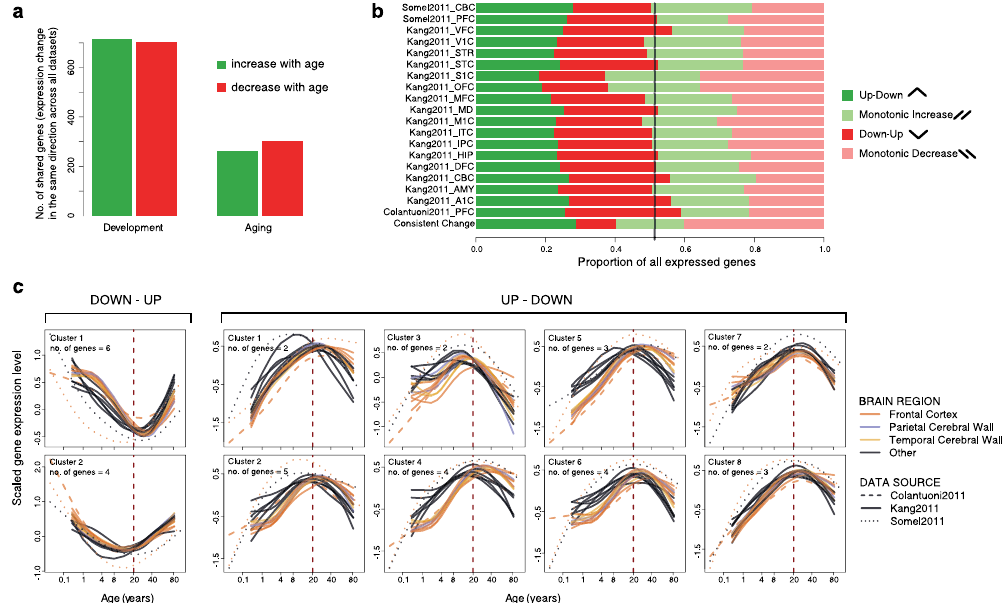
Figure 2. Shared expression changes with age and shared reversals. ( a ) The number of consistent expression changes in development and aging. Interestingly, there is a trend toward 1.7% more consistently up-regulated genes during development, and 12.3% more consistently down-regulated genes during aging. This was also in line with 16/19 datasets harboring more up-regulated significant genes during development, and 10/12 datasets harboring more down-regulated significant genes during aging (Figure S2). ( b ) The proportion of different trends in age-related expression change in each dataset and among the genes showing consistent change across datasets. No effect size or significance cutoff was used. Up-down: up-regulation in development and down-regulation in aging; Down-up: down-regulation in development and up-regulation in aging; Monotonic increase: up-regulation in development and up-regulation in aging; Monotonic decrease: down-regulation in development and down-regulation in aging. ( c ) Average expression trajectories of consistent reversal gene clusters, plotted against individual age. The x-axis shows the age of samples on the fourth root scale and the y-axis shows the scaled mean expression level for each cluster. The spline curves indicate the mean expression change with age for each dataset and brain